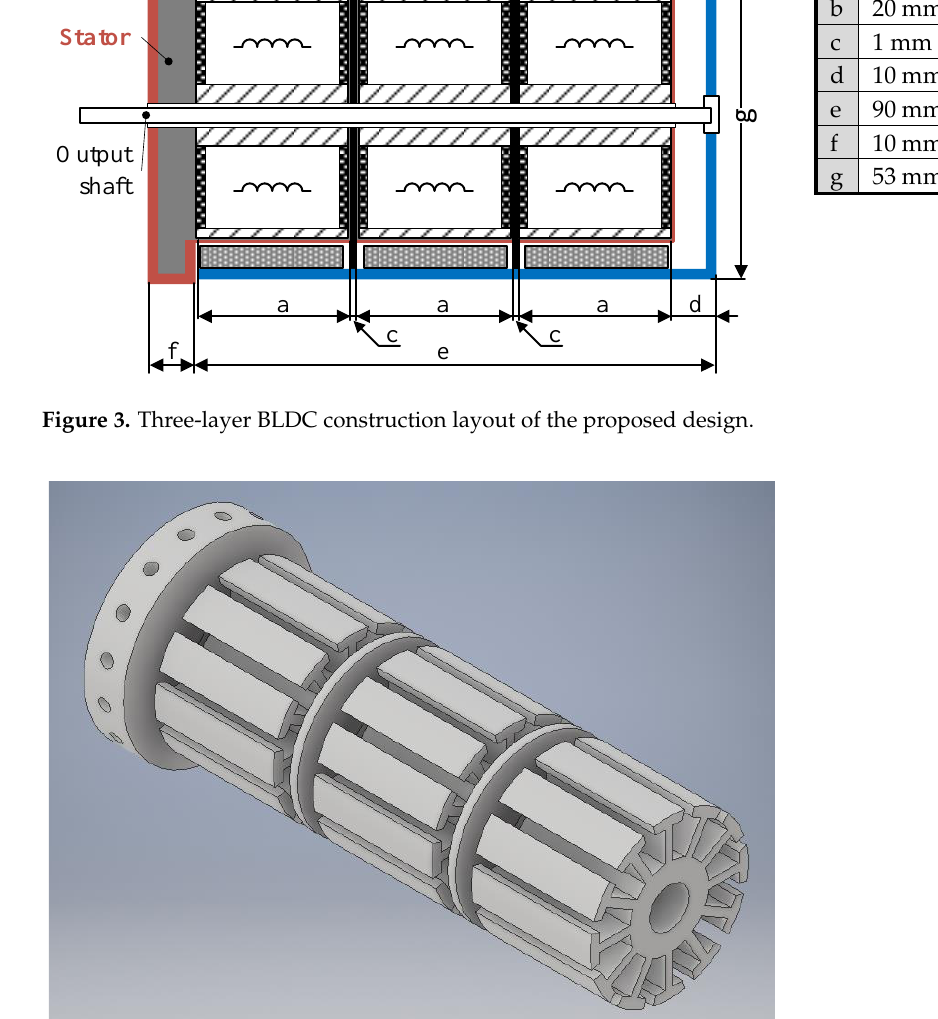
Figure 3. Three-layer BLDC construction layout of the proposed design .